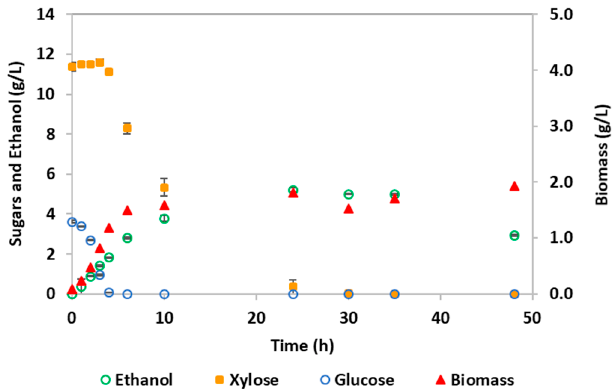
Figure 4. Time course of E. coli MS04 fermentation using the LB synthetic medium, glucose, xylose, bioethanol and biomass concentrations (45 mL, 150 rpm, initial pH 7 and 37 °C).